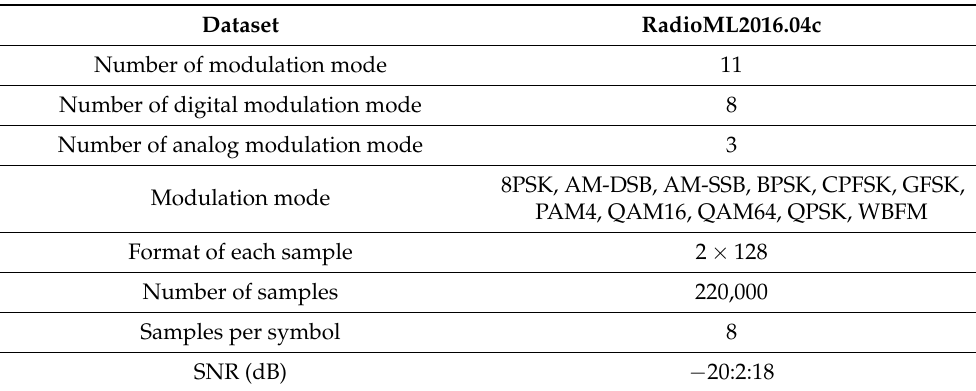
Table 6. Description of display parameters for Radio2016.04c dataset. Dataset